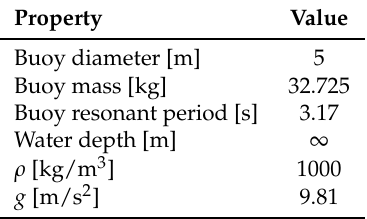
Table 1. Properties of the spherical point absorber in the simulation environment.